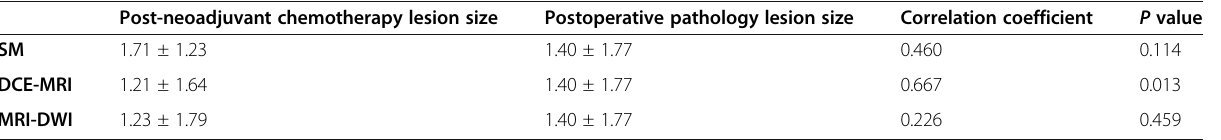
Table 5 Correlations between lesion size measured by different imaging modalities and postoperative pathology result in the neoadjuvant goup Post-neoadjuvant chemotherapy lesion size